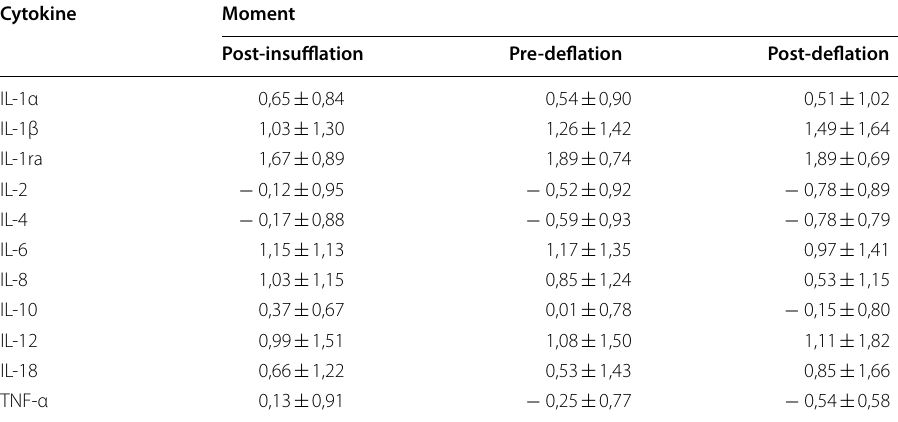
Data are presented as z -score mean